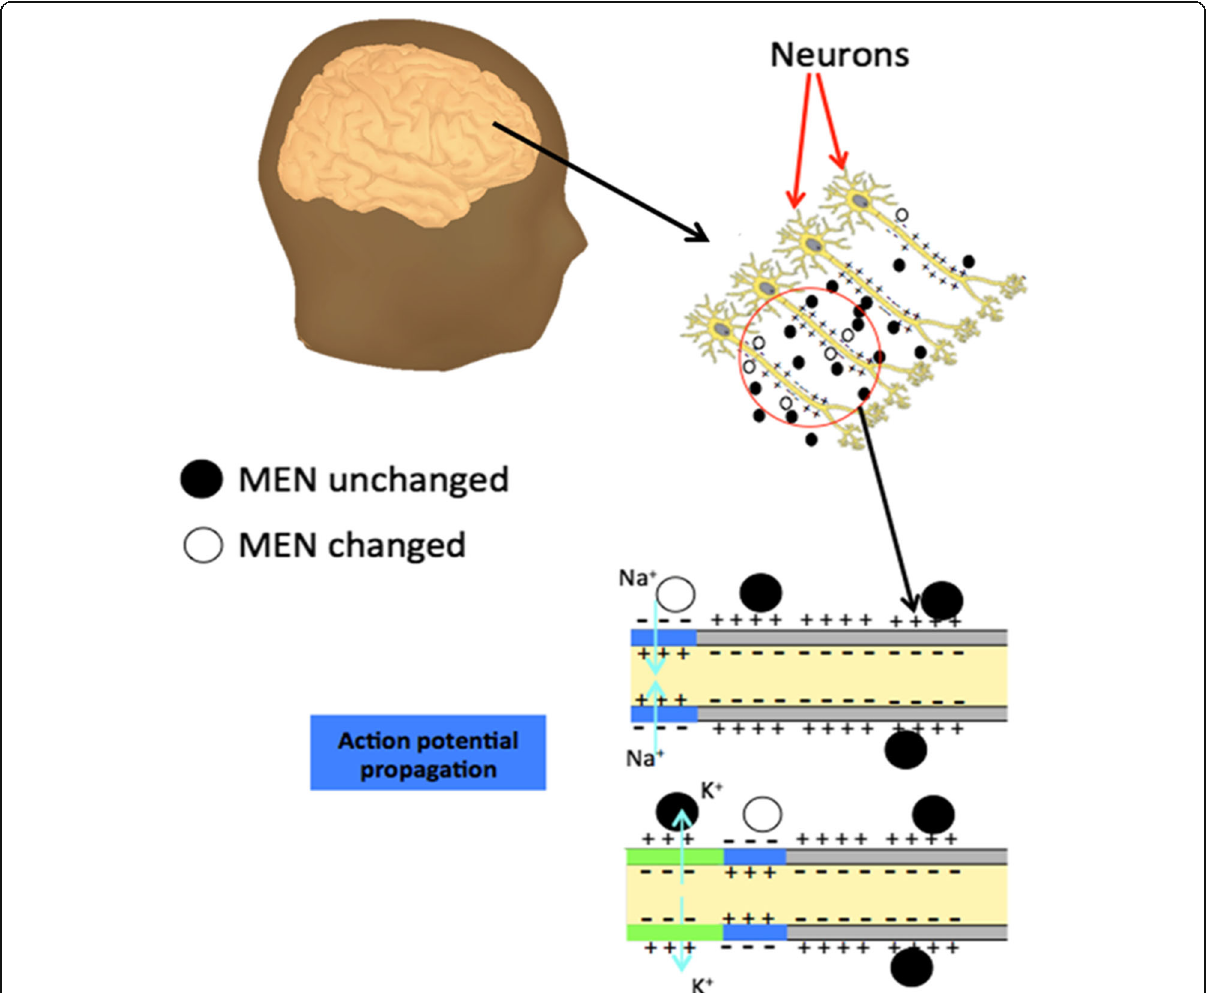
Fig. 1 A schematic illustrating how MENs can be used to detect the electric field due to the neural activity deep in the brain. The exaggerated illustration shows how the magnetic moment of a MEN in the proximity of the membrane can be reversed by flipping the local electric field as the action potential travels by the MEN